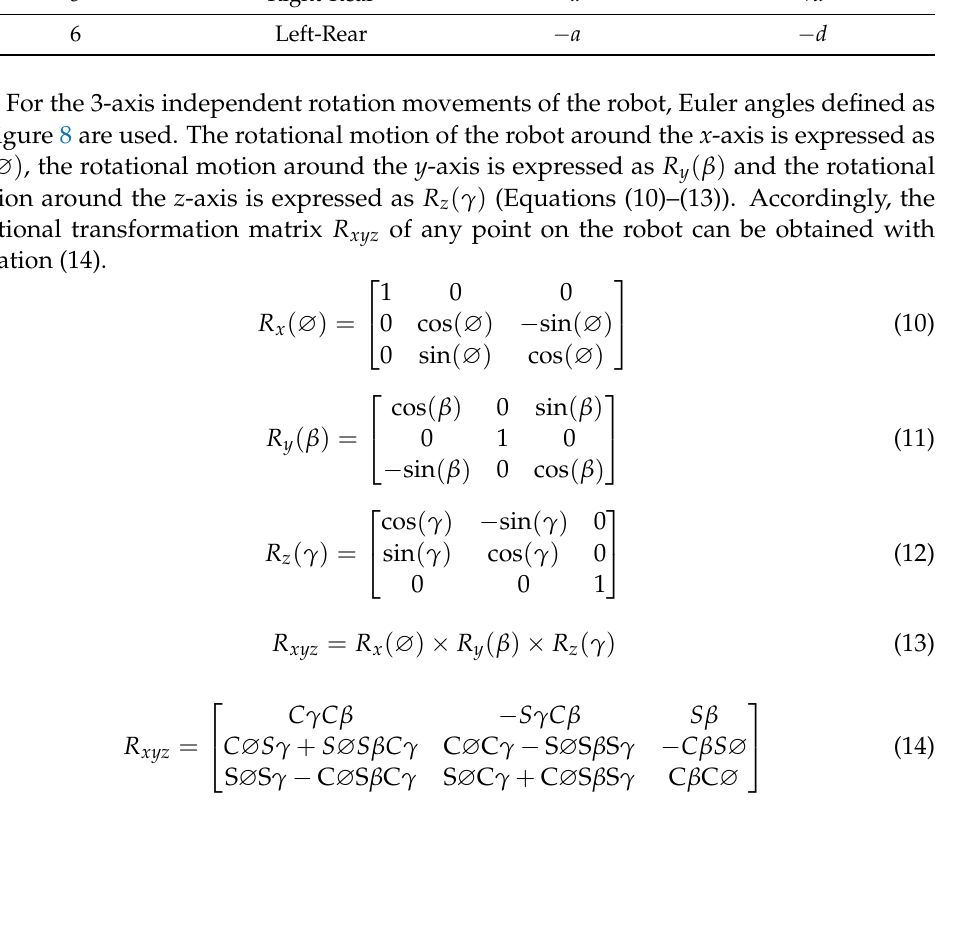
Table 4. Parameter differences for wheels. Wheel Position Parameters 1 Right-Front a + d 2 Left-Front a − d Right Middle a = 0 + d Left Middle a = 0 Right-Rear − a + d Left-Rear −